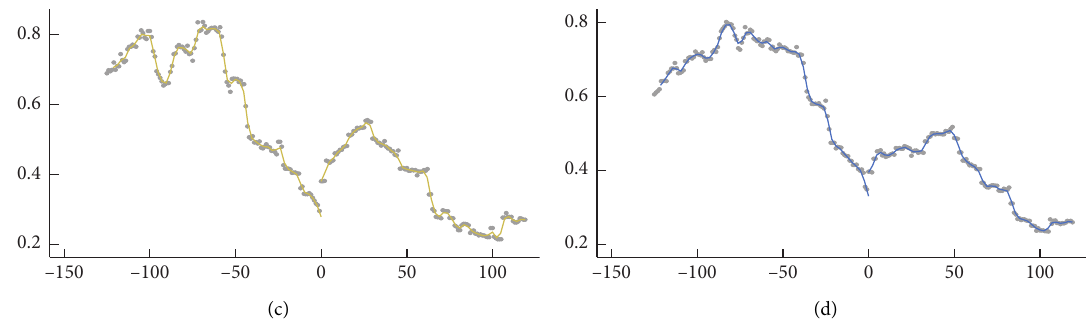
Figure 8: The RDD results of the information industry. (a) hv5, (b) hv15, (c) hv30, and (d) hv50.